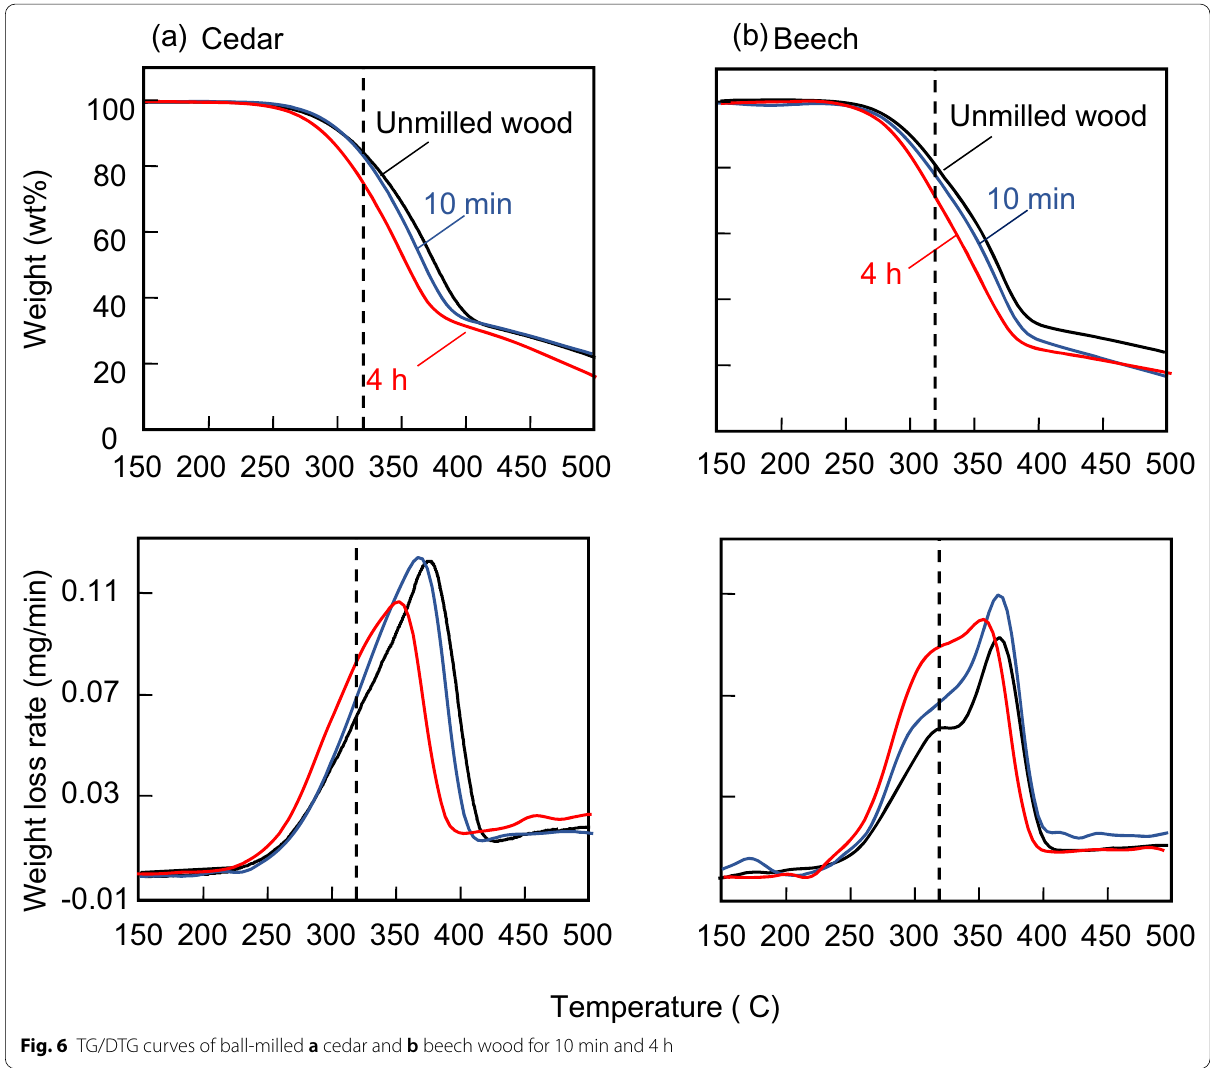
Fig. 6 TG/DTG curves of ball-milled a cedar and b beech wood for 10 min and 4